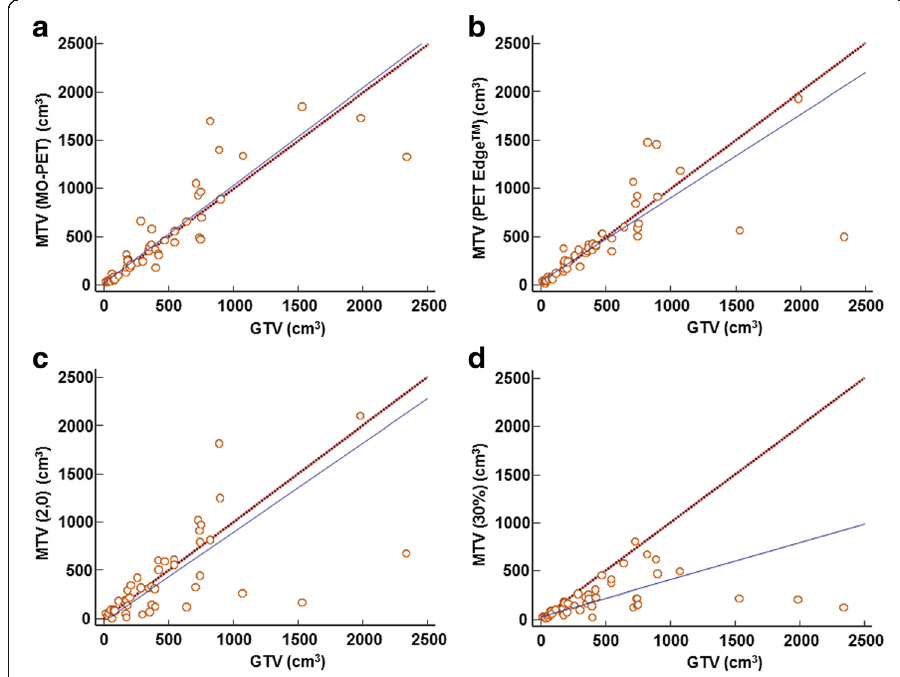
Fig. 1 Spearman correlation for MTV and GTV. a MO-PET. b PET Edge ™ . c Absolute SUV threshold value of 2.0. d Percentage of SUV max value of 30%. A significant positive correlation is exhibited between each MTV and GTV. Solid line, trend line; dotted line, line of